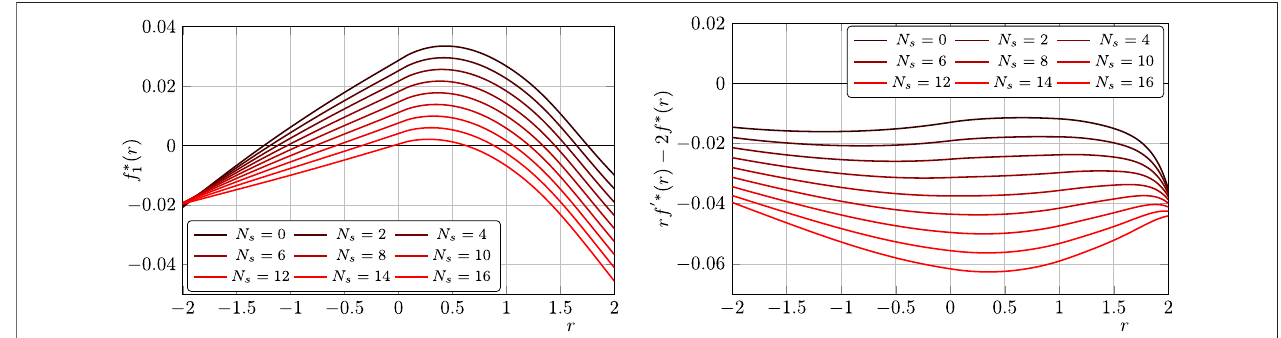
FIGURE2| Displayedarethepotentialoftheone-pointfunctionandthederivateofthebackgroundpotentialfordifferentnumbersofscalar fi eldsatthe fi xedpoint, as de fi ned in 57 and 59 . A zero in these functions indicates a solution to the quantum and background EoM, respectively. While the former always has two solutions, a minimum at negative curvature and a maximum at positive curvature, the latter shows no solution at all. The fi gures are taken from